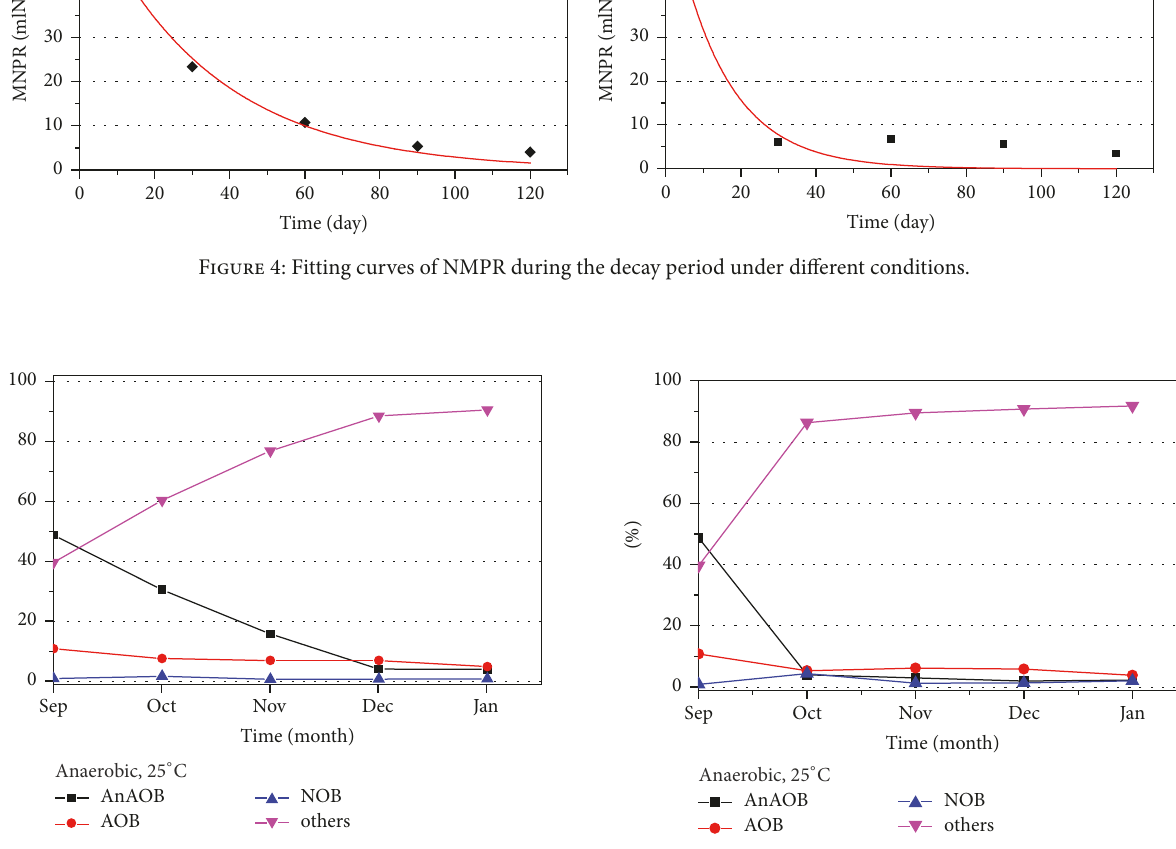
Figure 6: Proportion variation of species in the total functional microbial communities under aerobic